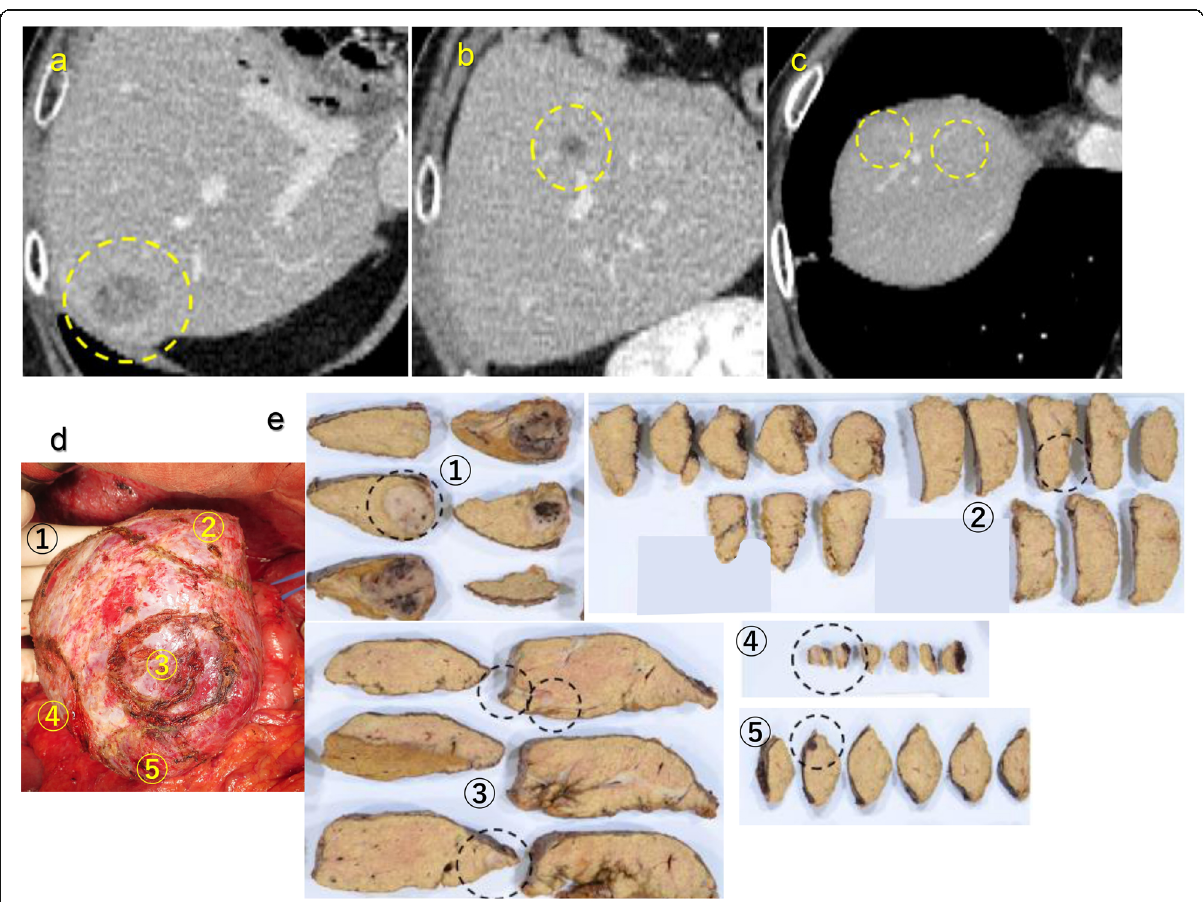
Fig. 4 Third operation. a – c CT detected four liver metastases as recurrence of NET. The tumor was in segments 6, 5, and 8. d Intraoperative findings showed three other metastases; five limited liver resections were performed for the tumors. e Pathological findings showed seven tumors in the resected specimen which meant that there were 3 other metastases in the resected